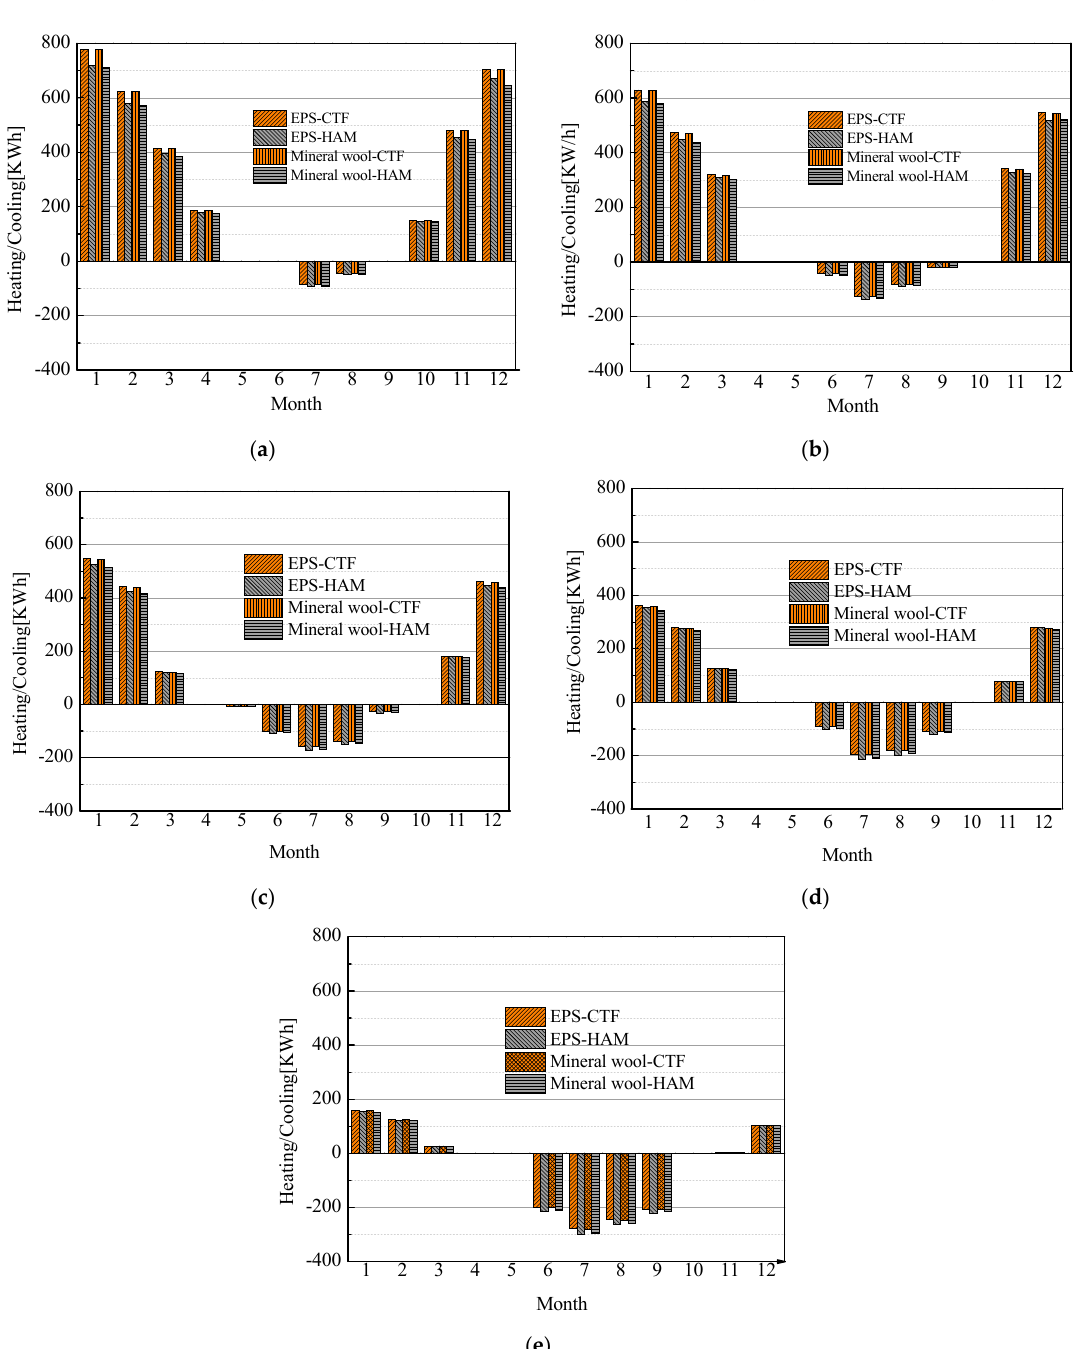
Figure 7. Heating and cooling month energy in the 101 room: ( a ) Harbin; ( b ) Shenyang; ( c ) Beijing; ( d ) Shanghai; ( e ) Guangzhou.